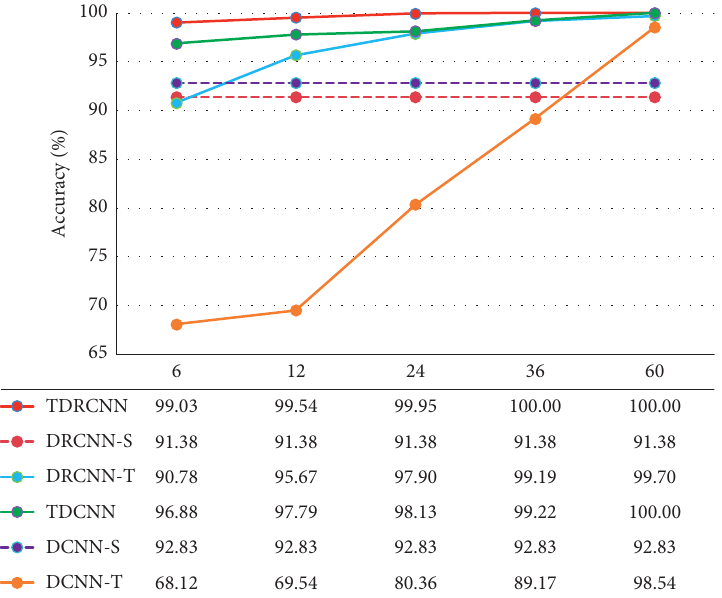
Figure 11: Testing accuracies obtained by different networks with different numbers of training samples in the target domain for transfer task A ⟶